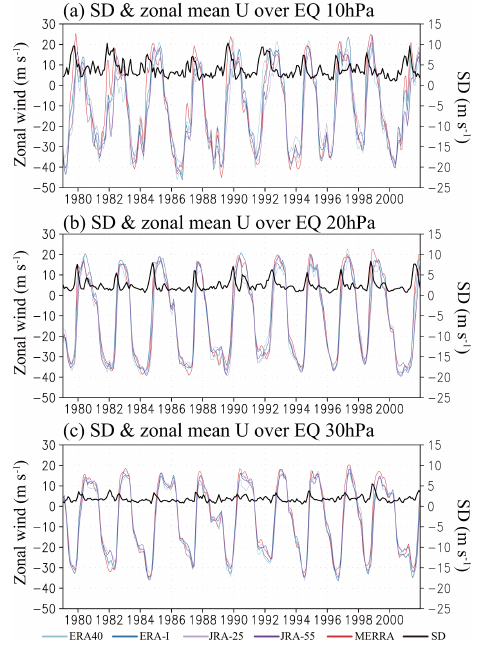
Figure 8. Zonal mean equatorial zonal wind in each reanalysis (col- ors) and zonally averaged equatorial standard deviation among re- analyses (black) at (a) 10, (b) 20, and (c) 30hPa. Figure 9. Top: composite of the QBO in the zonal wind at 10hPa